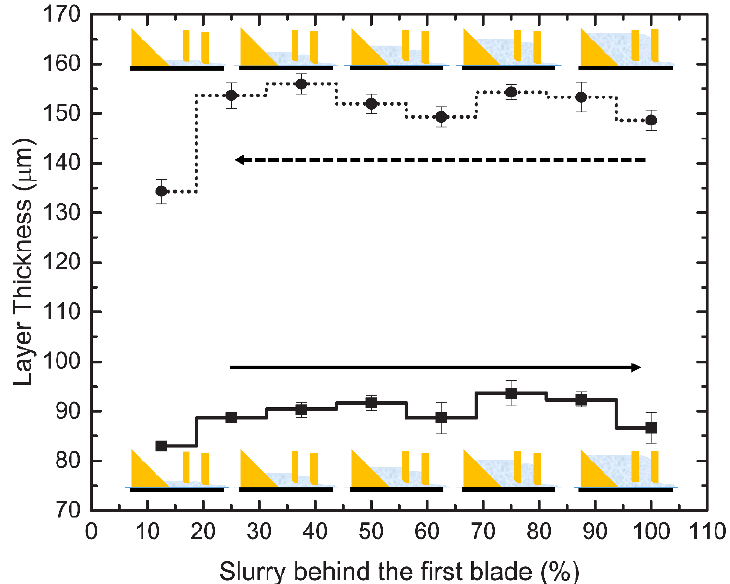
Figure 5. Film thickness measurement on the tape versus slurry level behind the first doctor blade. First with ascending level ( solid line ); second with descending level ( dotted line ).